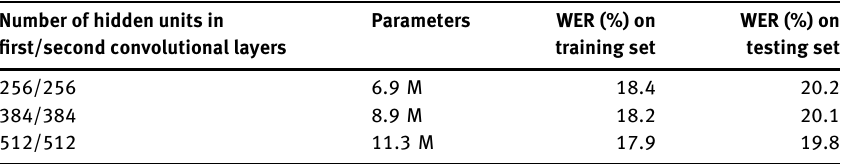
Table 2: WER as a Function of Number of Hidden Units. Number of hidden units